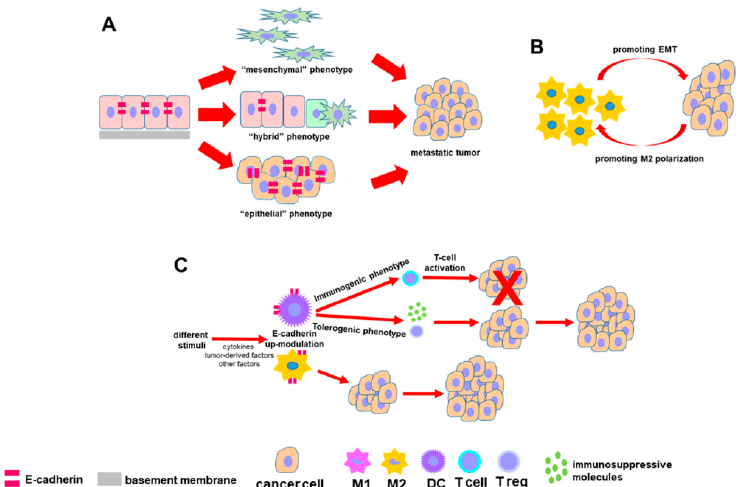
Figure 5. Diagram summarizing the relationship between E-cadherin expression and the key events of EMT. The involvement of E-cadherin and its interplay within the immune cells in tumor microenvironment possibly influencing the PDAC cell fate is also included. ( A ) E-cadherin di ff erently influences the behavior of cancer cells having a di ff erent EMT-related cell phenotype. ( B ) Macrophages and pancreatic tumor cells establish a bidirectional cross-talk: The former promotes EMT in cancer cells and, in turn, the latter influences macrophage polarization toward a M2 phenotype. ( C ) In DCs, E-cadherin expression can be associated either with an immunogenic phenotype able to promote an e ffi cacious immune response against tumor, either with a tolerogenic phenotype that suppresses the immune response supporting tumor growth. In macrophages, E-cadherin up-regulation is usually correlated with a M2 protumor